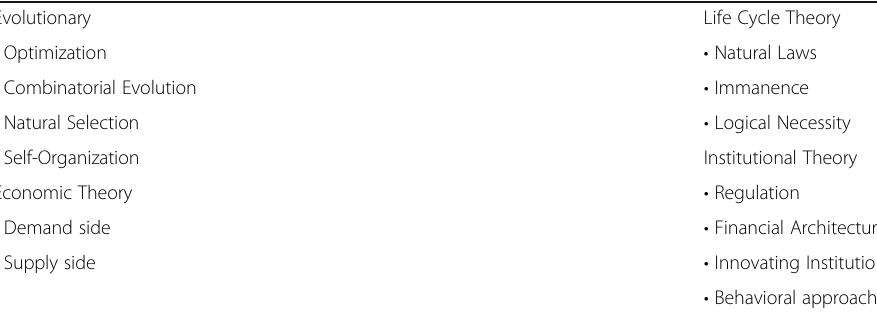
Table 1 Financial innovation development theories Evolutionary Life Cycle Theory